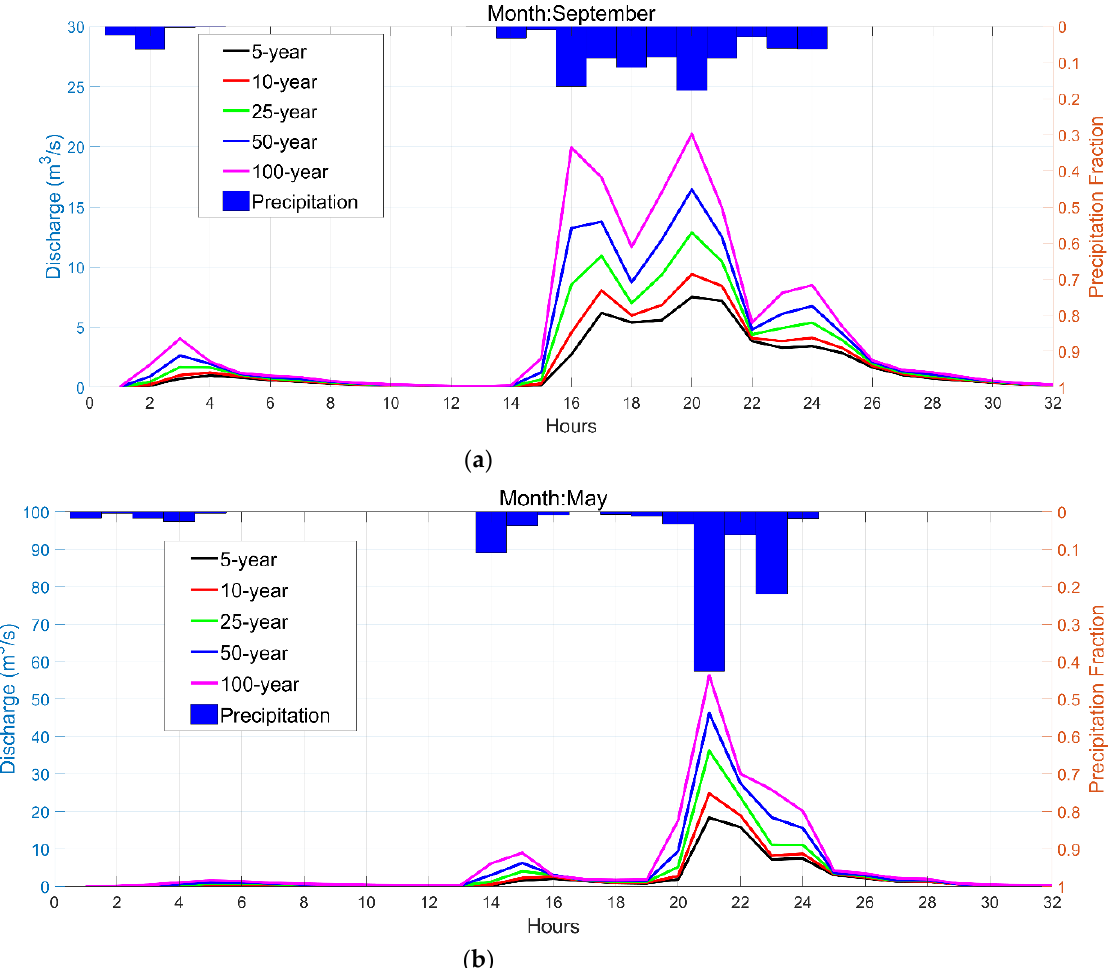
Figure 9. Hydrograph of flow discharge at the outlet of the study area for different design storms with precipitation fraction in ( a ) May and ( b ) September.